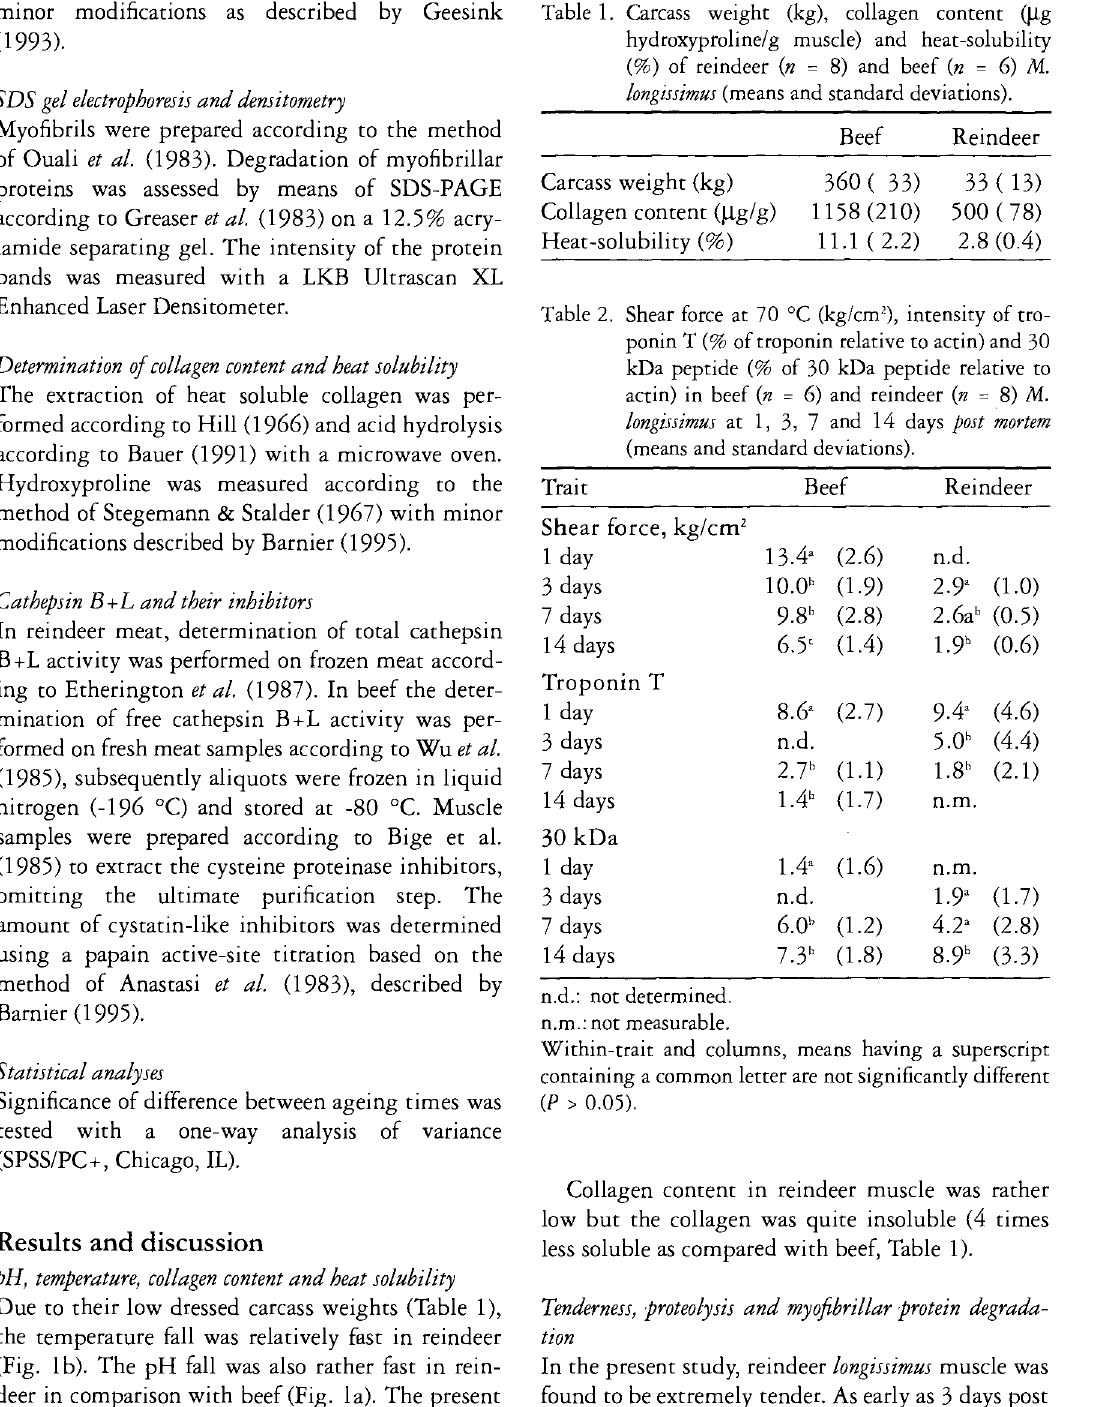
Table 2. Shear force at 70 °C (kg/cm 2 ), intensity of tro ponin T (% of troponin relative to actin) and 30 kDa peptide (% of 30 kDa peptide relative to actin) in beef (n = 6) and reindeer (n = 8)